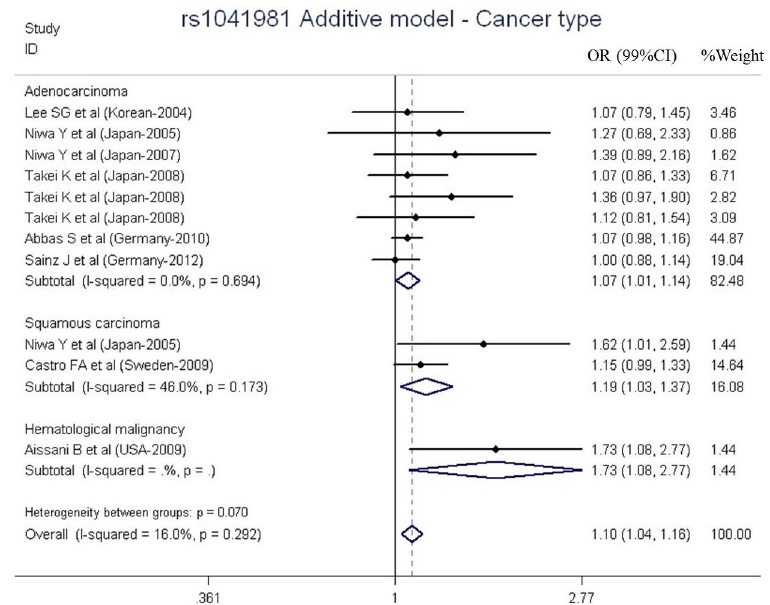
Figure 2. Meta-analysis of LTA rs1041981 polymorphism and cancer risk in the additive model stratified by cancer